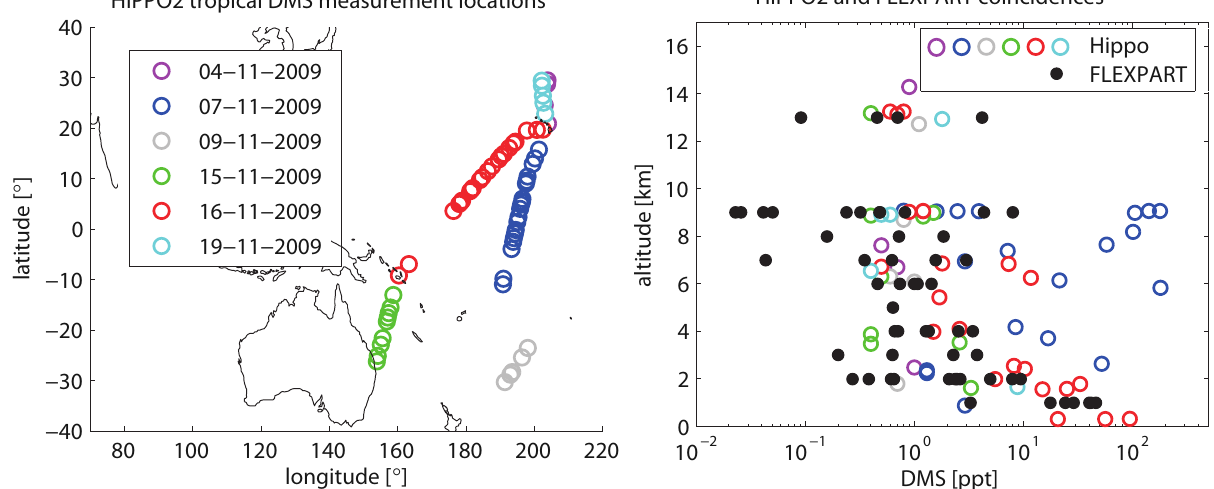
Fig. 1. Comparison between HIPPO2 atmospheric DMS observations and FLEXPART DMS simulations (1 / 2 day atmospheric lifetime). Measurement locations for HIPPO2 (left panel) and comparison between HIPPO2 and FLEXPART coincidences (right panel) are shown. Note: DMS (ppt) of right panel is logrithmic.